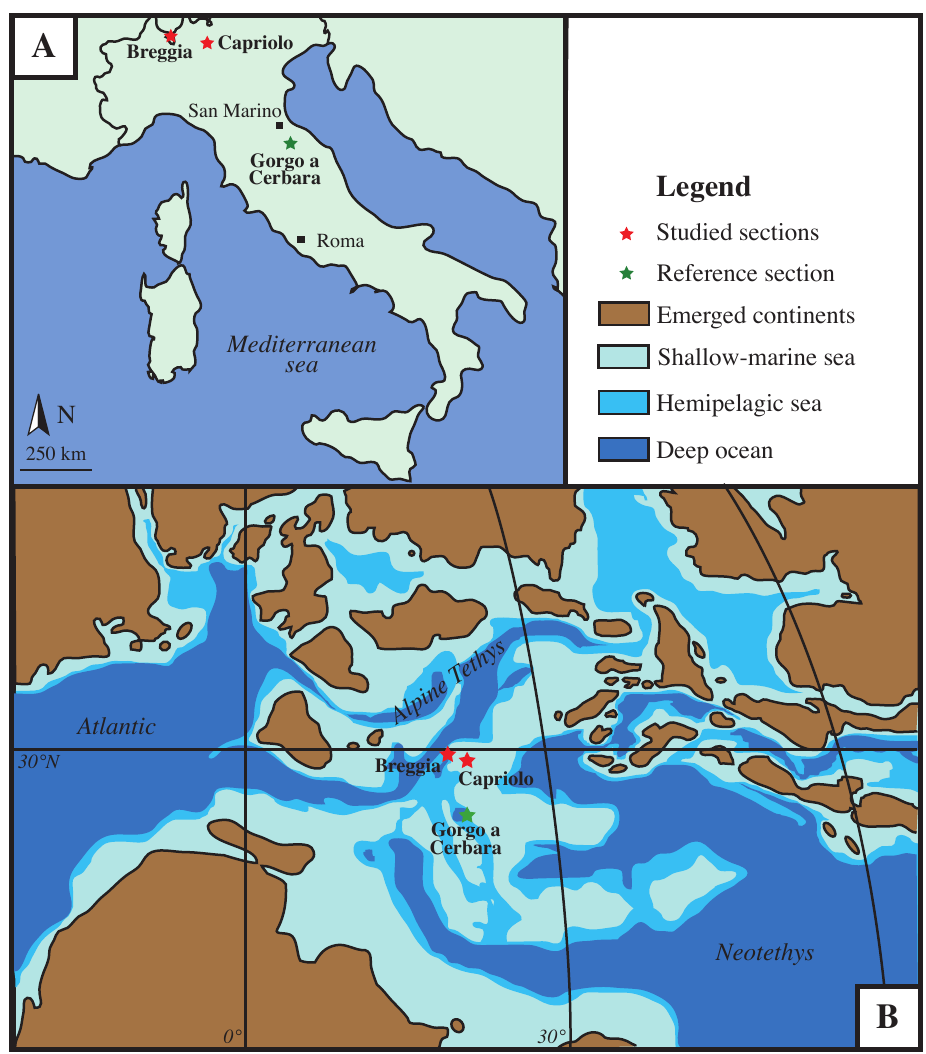
Fig. 1. Location of the studied sections and a reference section on a geographic map (A) and on a paleogeographic reconstruction for the early Aptian from Blakey (http://cpgeosystems.com/paleomaps.html) (B) . Modified from Stein et al.